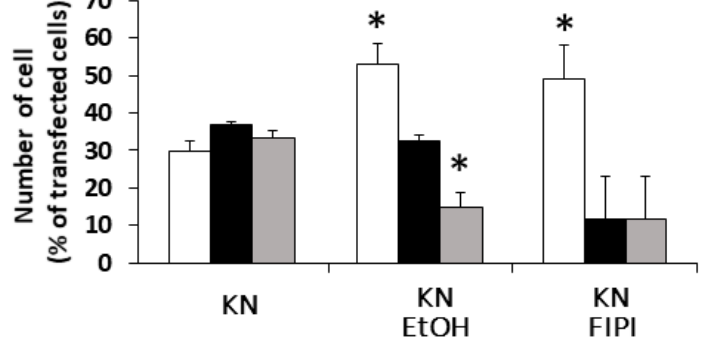
Figure 5. Effects of Phospholipase D (PLD) inhibitors on the DGK β KN-induced neurite induction. The plasmid of GFP-DGK β KN was transfected into SHSY-5Y cells. After 24 h, EtOH or FIPI was added to make a final concentration 0.3% and 1 μ M respectively, and further cultured for 24 h. More than 100 cells were observed in each experiment and three independent experiments were performed. White, black and gray columns show percentage of the number of cells having no, one or two and several neurites, respectively. The mean and SEM of the number of the cells are shown as percentage to the transfected cells. * p < 0.05, followed by Student’s t -test (vs. the control expressing GFP-DGK β KN).